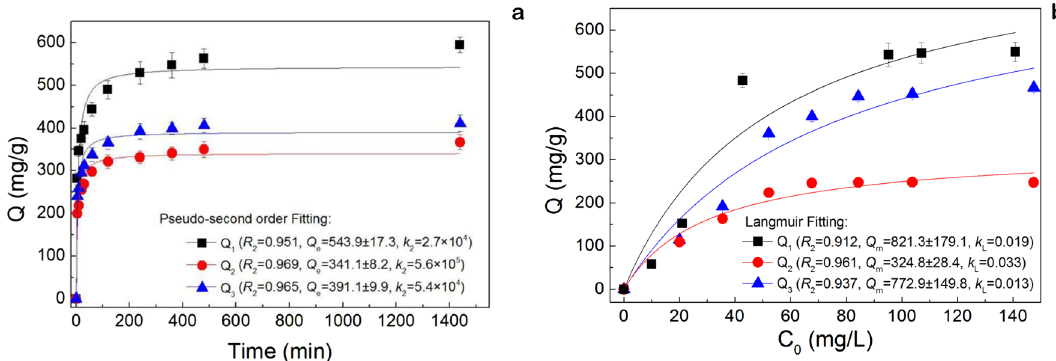
Figure 3. ( a ) Sorption kinetics and ( b ) isotherms obtained at adsorbent loadings of 0.05–0.1 g L −1 and initial Sb concentrations of 0–160 mg L −1 .